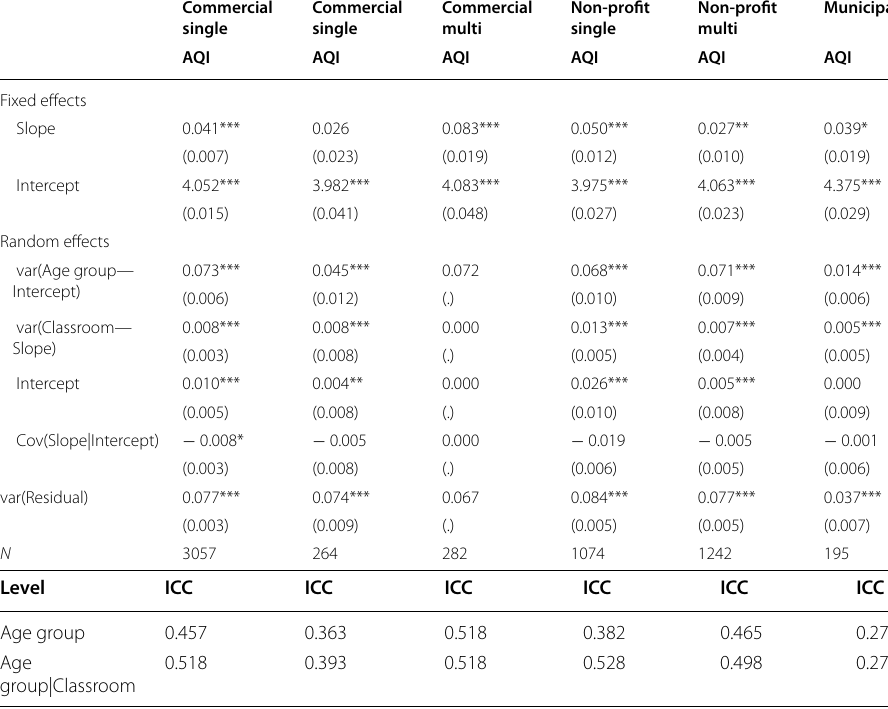
Table 5 AQI growth model for all classrooms, and stratified by centre type; with intraclass correlations on age group and classroom